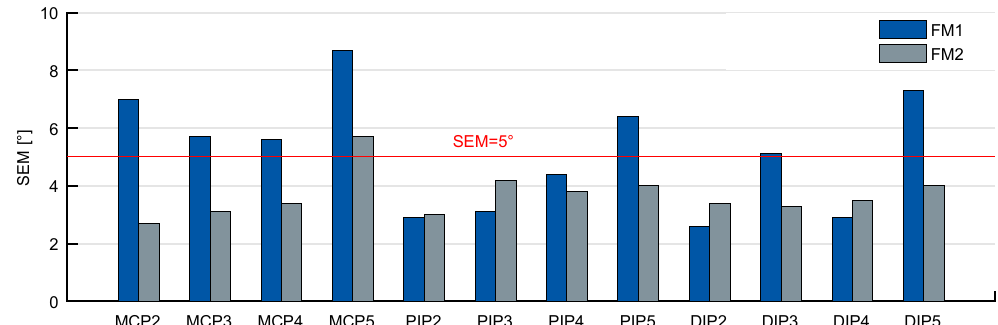
Figure 4. SEM for the ROM in flexion of the finger joints over all subjects for FM1 and FM2. The number of analyzed subjects was different between the two studies (FM1: n = 11; FM2: n = 20).